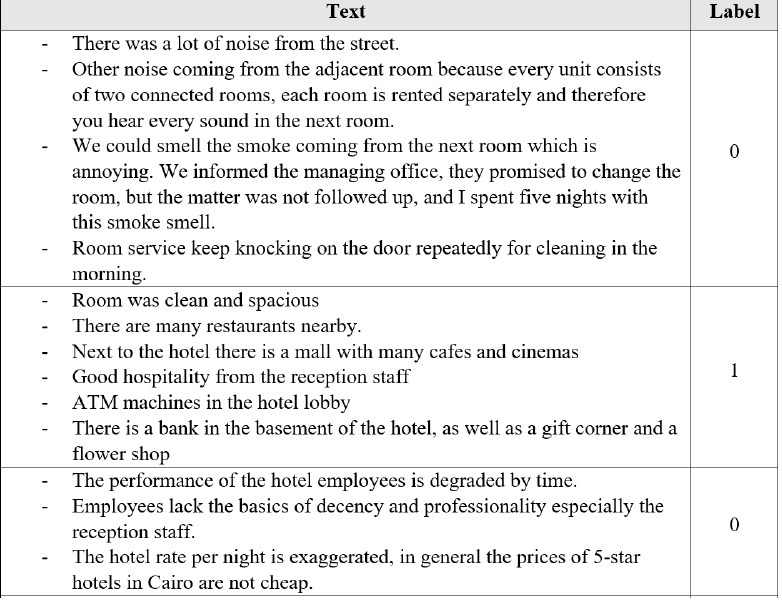
Figure 4. English translation of sample records of our constructed dataset